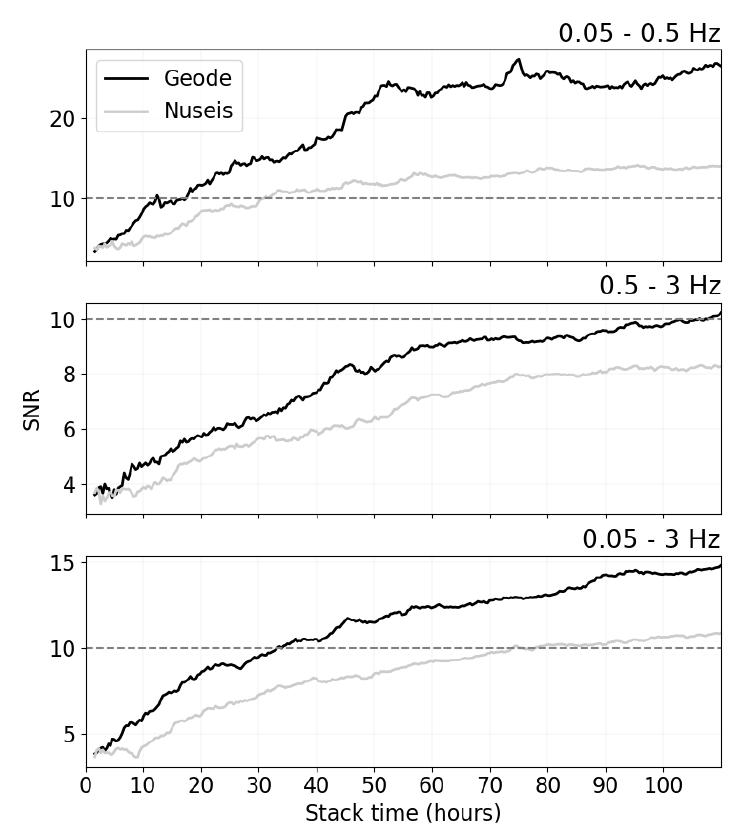
Figure 6. Comparison of the SNR of the average of the 6 Geode correlation functions (black) and those of the Nuseis correlation functions (grey) for three different frequency bands. The black dashed line indicates an SNR of 10, which is the threshold for making dispersion